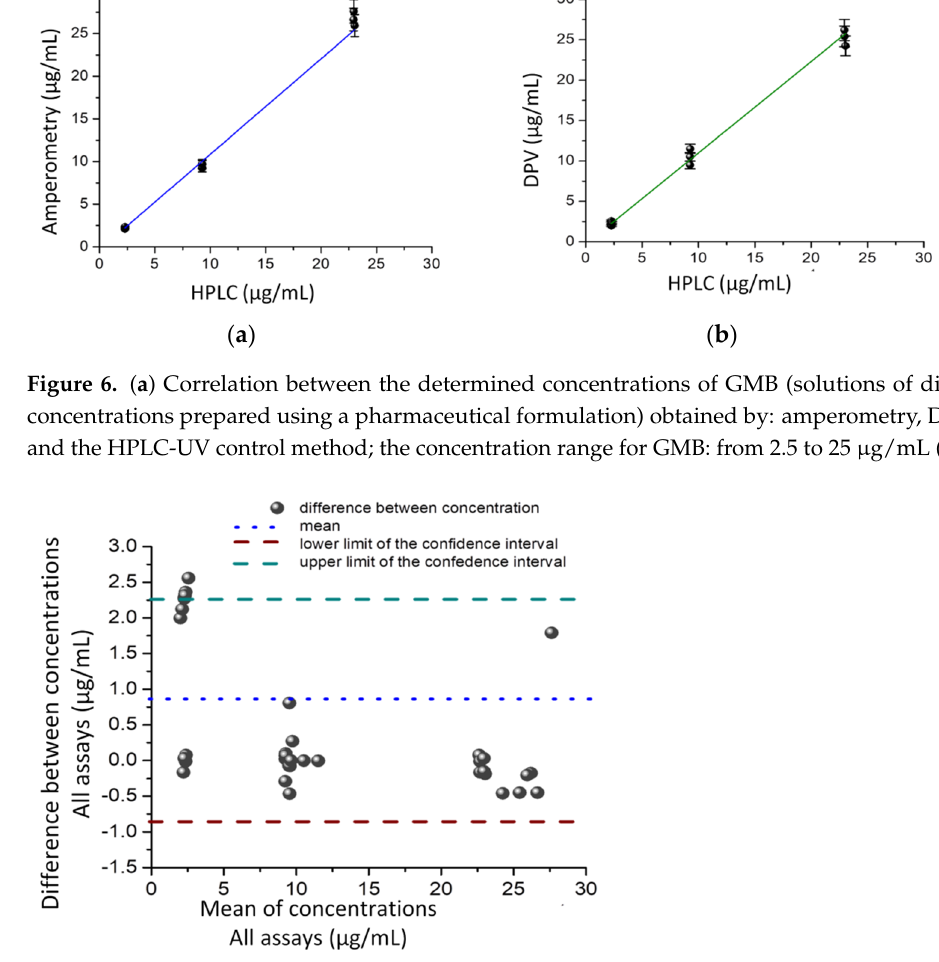
Figure 6. ( a ) Correlation between the determined concentrations of GMB (solutions of different concentrations prepared using a pharmaceutical formulation) obtained by: amperometry, DPV ( b )